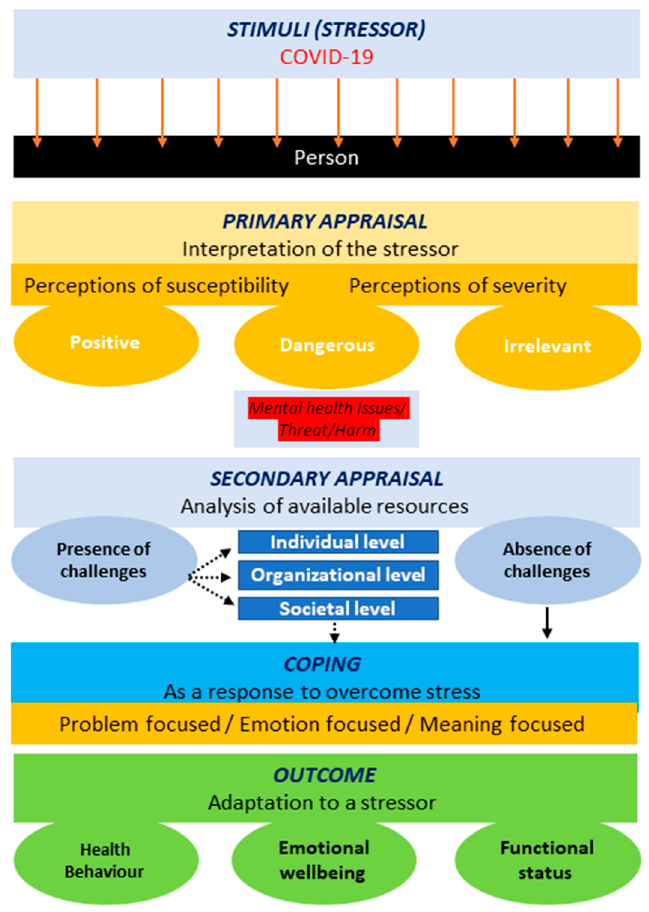
Figure 1. Adapted transactional model of stress and coping [28].